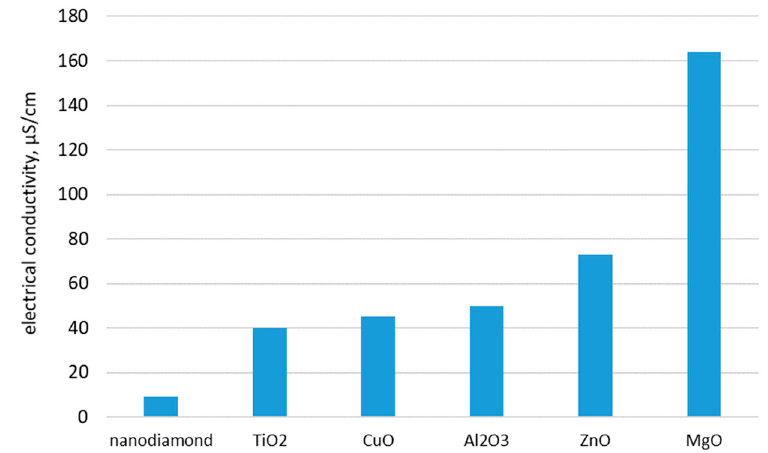
Figure 3. Comparison of electrical conductivity values for 0.01% nanofluid with different types of nanoparticles dispersed in water [36,39].